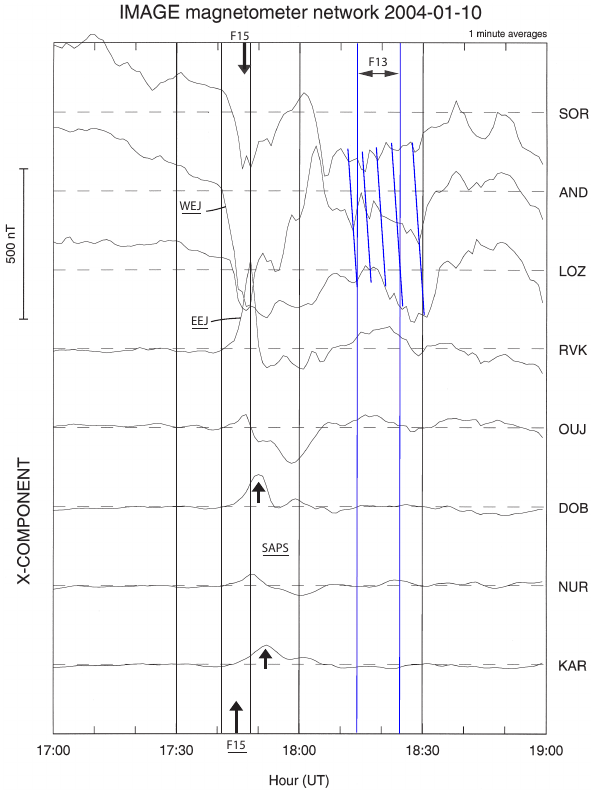
Fig. 10. X-component magnetograms from eight selected stations in the IMAGE chain of stations in Svalbard – Scandinavia – Russia for the interval 17:00–19:00UT. The station acronyms are marked on the right side. The onset of electrojet activity (WEJ at sta- tion AND) at 17:41UT and the maximum phase of the westward ( − 400nT at AND; 66.4 ◦ MLAT) and eastward (300nT at RVK; 62 ◦ MLAT) electrojet deflections at 17:48UT are marked by ver- tical guidelines. A series of auroral streamers in the interval 18:10– 18:30UT are shown by the blue tilted lines. Interval of F13 dusk- dawn crossing of the polar cap is marked by blue vertical lines.